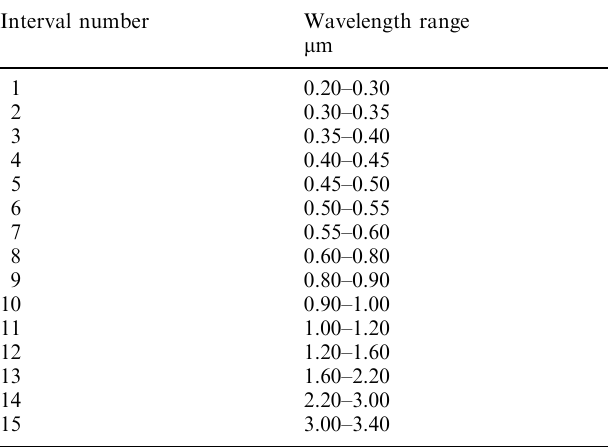
Table 6. Spectral resolution in the solar spectral range